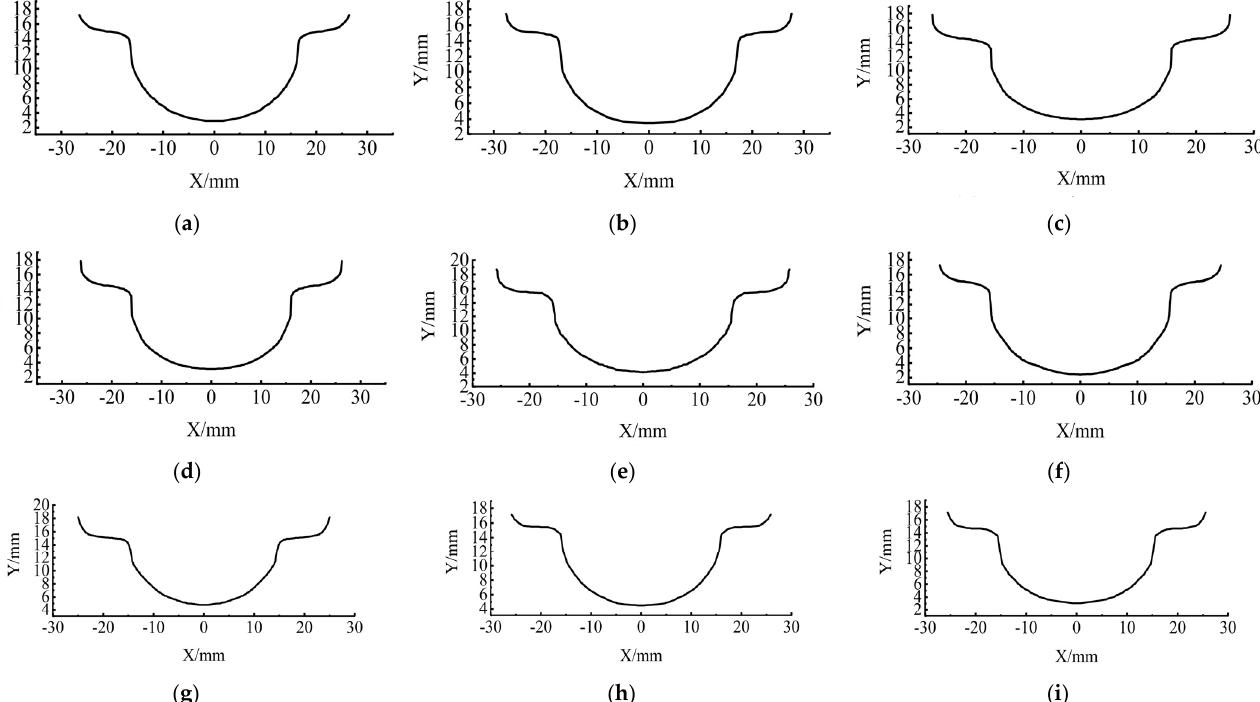
Figure 11. Surface coordinates under different viscosities. ( a ) v = 11 m/s η = 500 Pa·s; ( b ) v = 12 m/s η = 500 Pa·s; ( c ) v = 13 m/s η = 500 Pa·s; ( d ) v = 11 m/s η = 1000 Pa·s; ( e ) v = 12 m/s η = 1000 Pa·s; ( f ) v = 13 m/s η = 1000 Pa·s; ( g ) v = 11 m/s η = 2000 Pa·s; ( h ) v = 12 m/s η = 2000 Pa·s; ( i ) v = 13 m/s η = 2000 Pa·s.